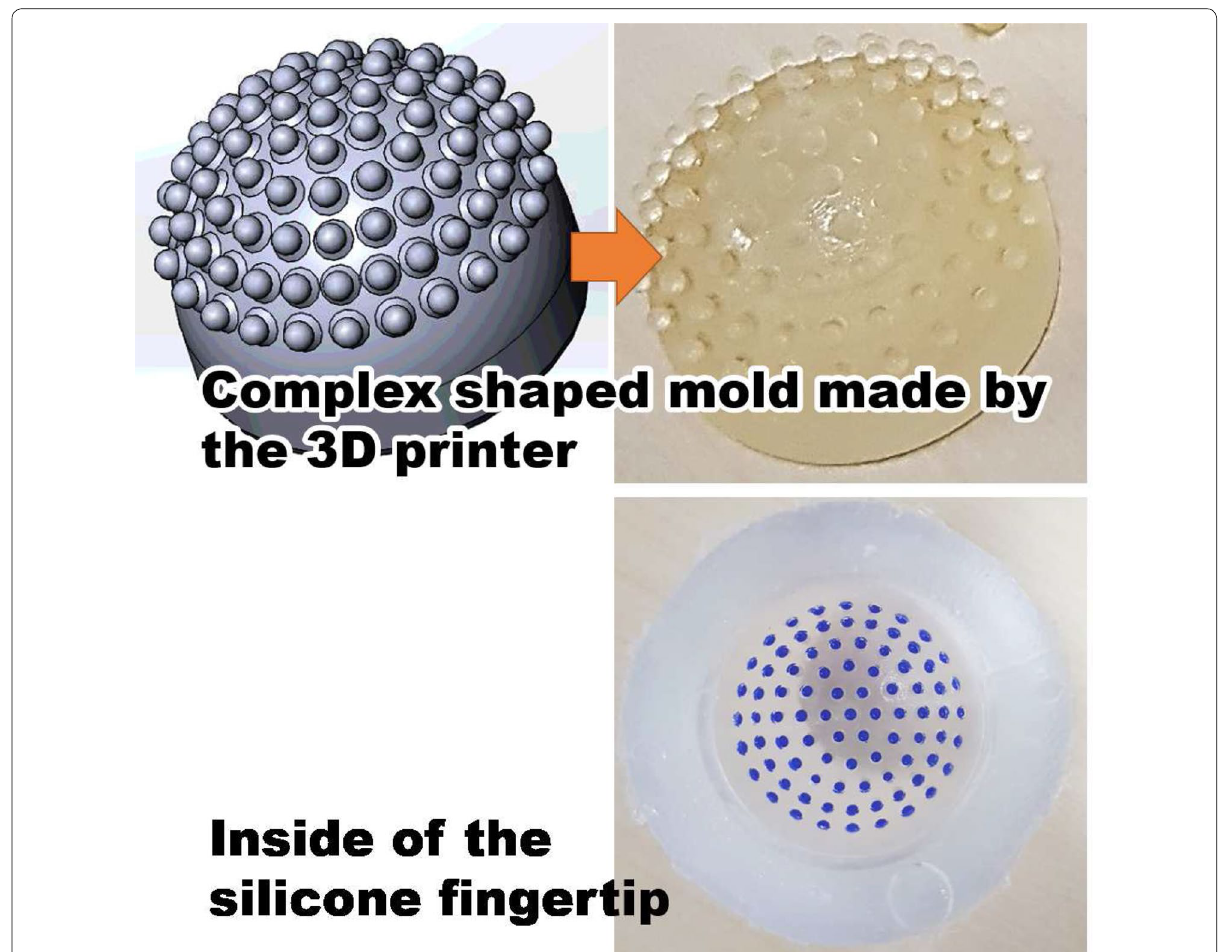
Fig. 2 Hemispheric silicone fingertip made by molding: there are 85 point markers inside the